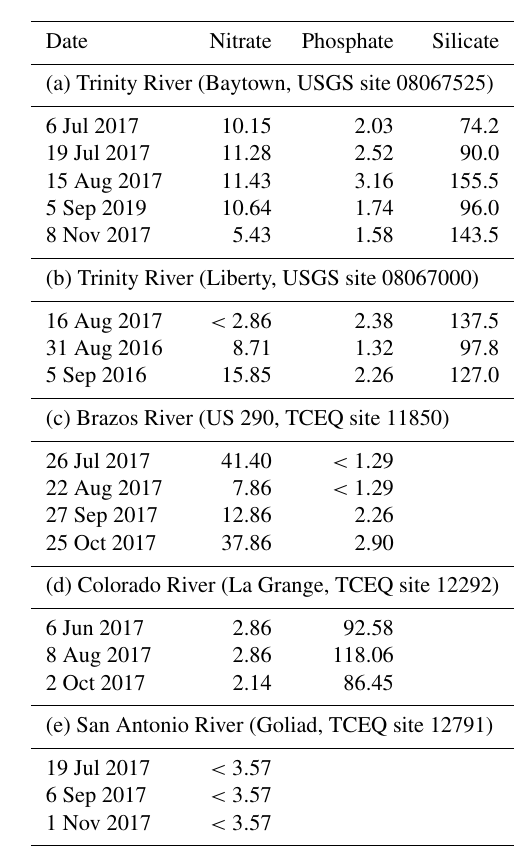
Table 3. Nutrient concentrations in Texas rivers around the time of the hurricane (µmolL − 1 ). Data taken from the USGS and the Texas Commission on Environmental Quality (TCEQ) Clean Rivers Program for individual river